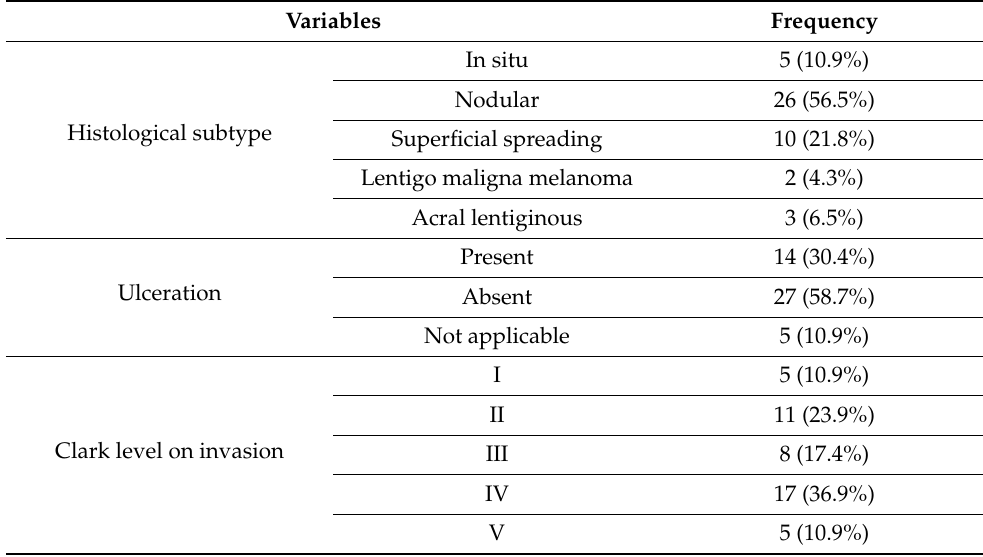
Table 1. Histopathological features of the evaluated cases.